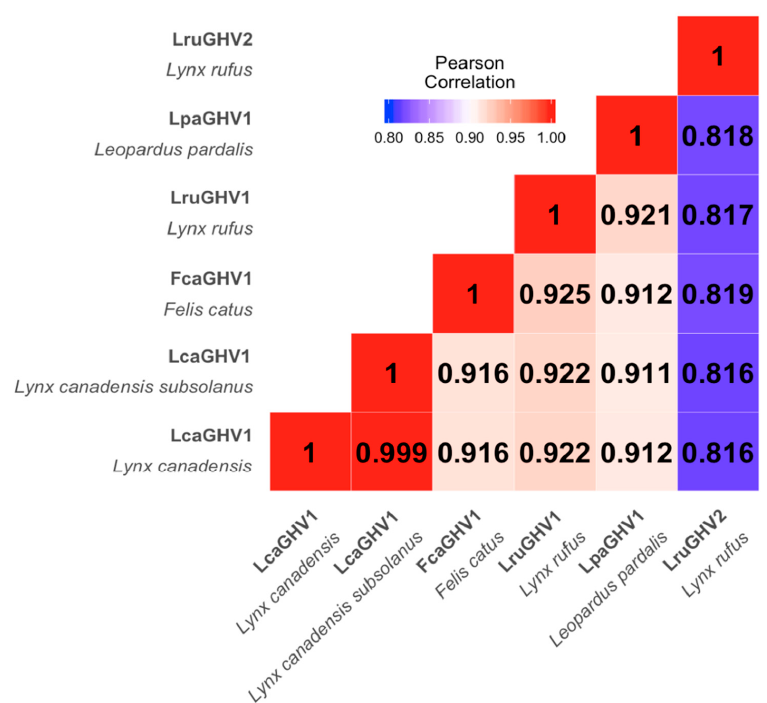
Figure 2 . Nucleotide sequence similarity between related percaviruses with felid hosts. T-Coffee was used to align the 3.4 kb sequence spanning from gB to DNApol (as described in Figure 1) for each virus. An identity matrix was calculated using BioEdit [31] and used to create this heat